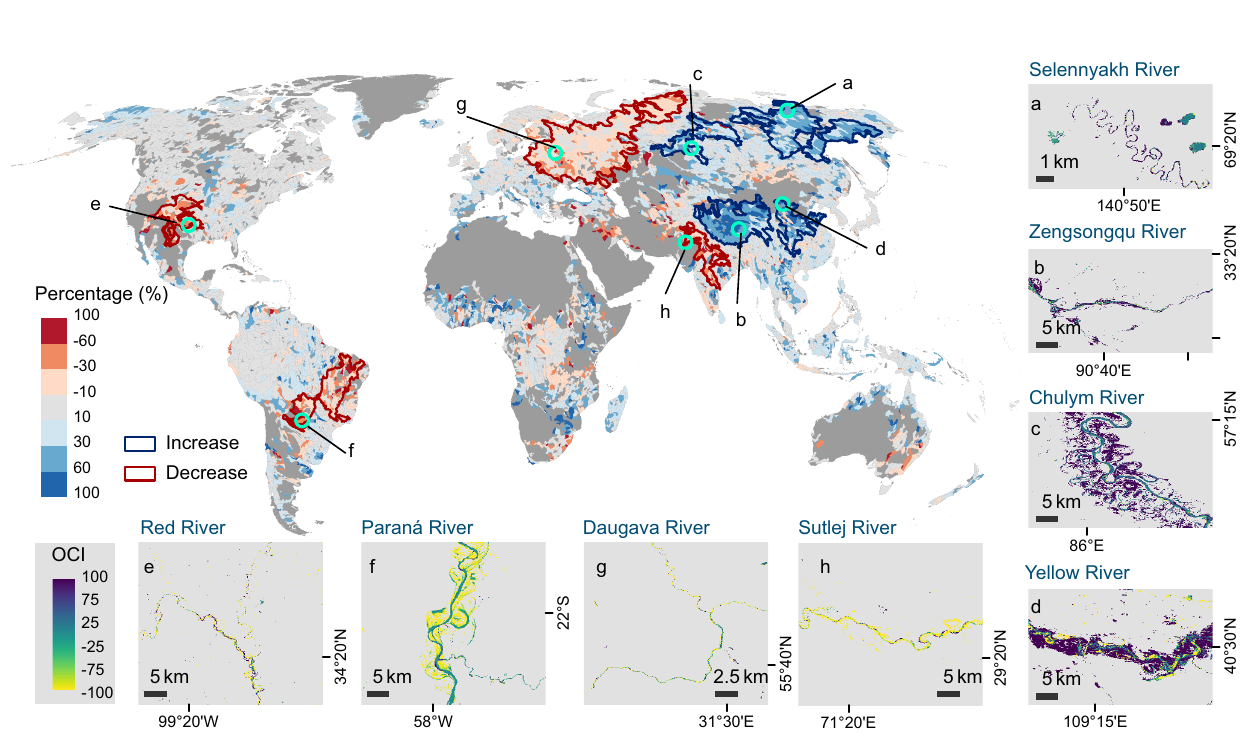
wide relative magnitudeofnetincrease (the areal differencebetween increase and decrease dividedbythe totalriver area). The green circles on the map indicate the locations of the zoom-in maps within the labeled hotspot